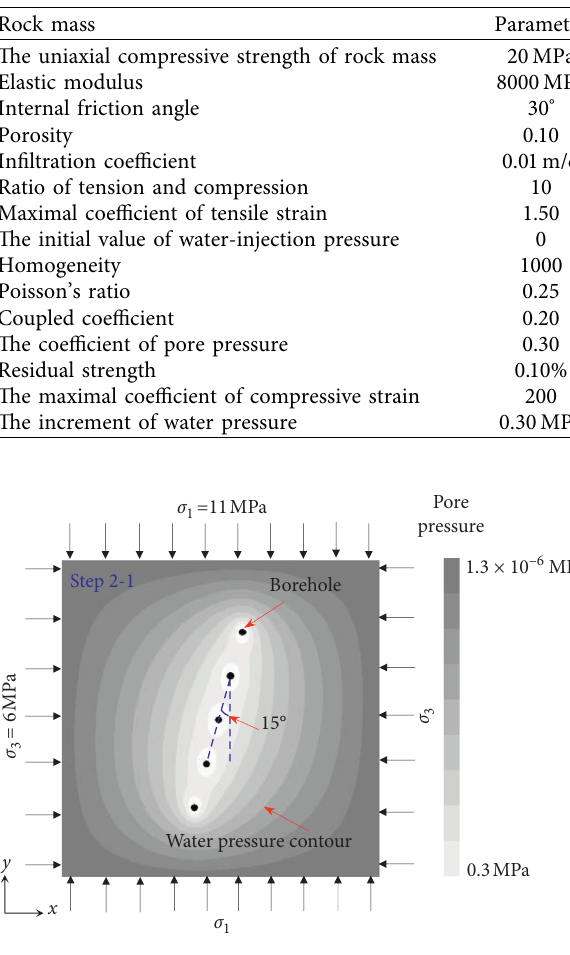
Figure 6: Numerical simulation